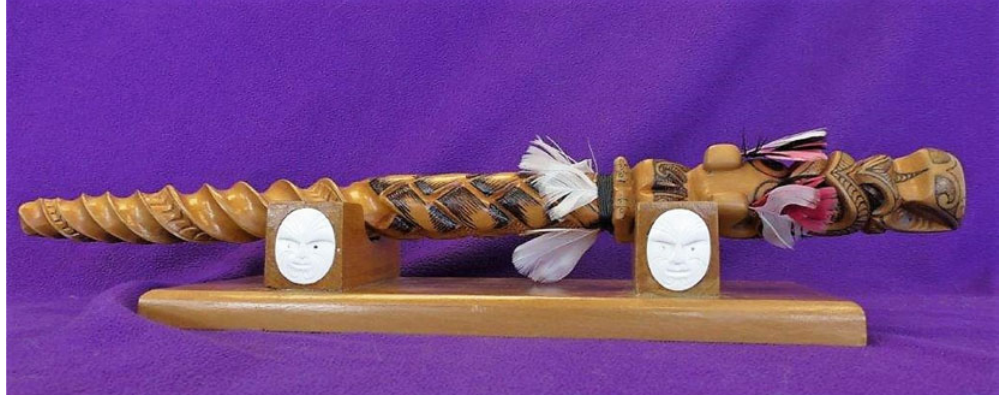
Fig. 1. Te Rangimarie, carved tokotoko , Massey University, Auckland. December 3,